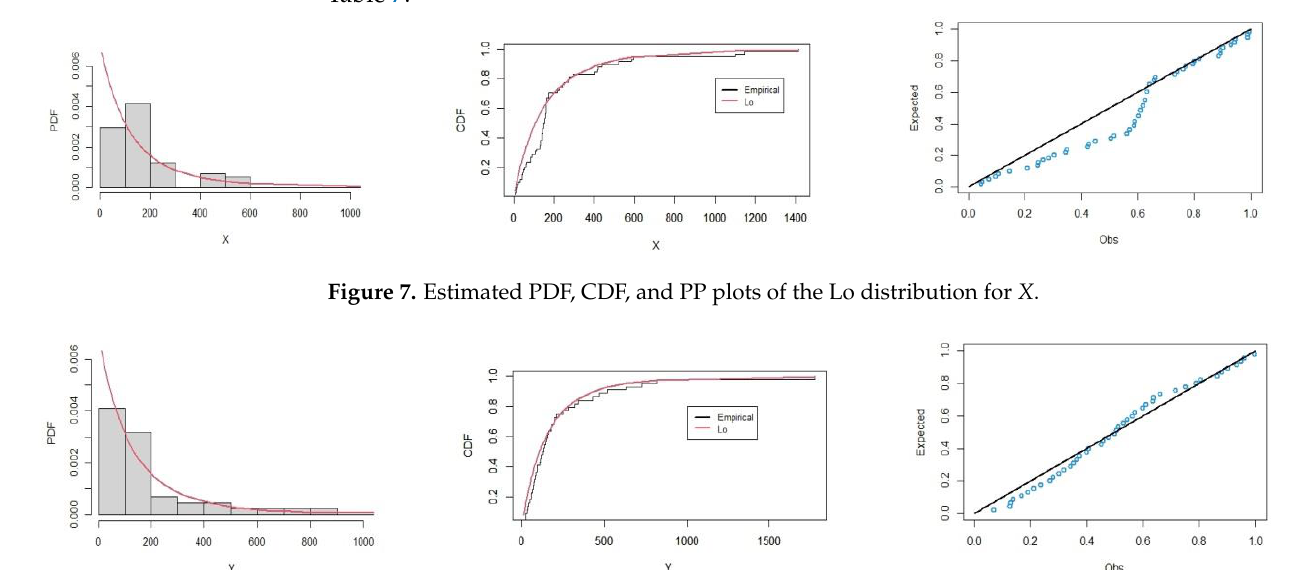
Figure 9. Estimated PDF, CDF, and PP plots of the ILo distribution for Z . Table 7. R eliability estimates, AB, MSE, and RE of the survival periods of two groups of patients with head and neck cancer data based on MRSS. ( n 1 , n 2 ) ( n 1 , n 3 )